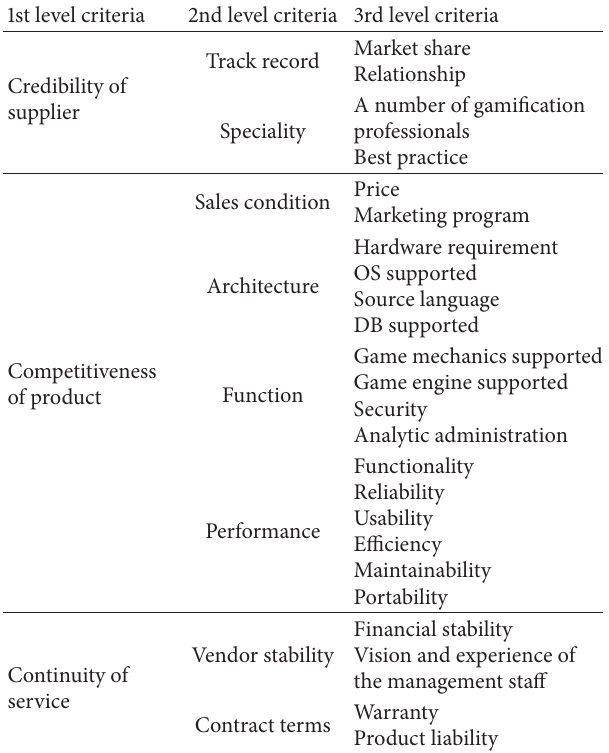
Table 3: Decision criteria for gamification